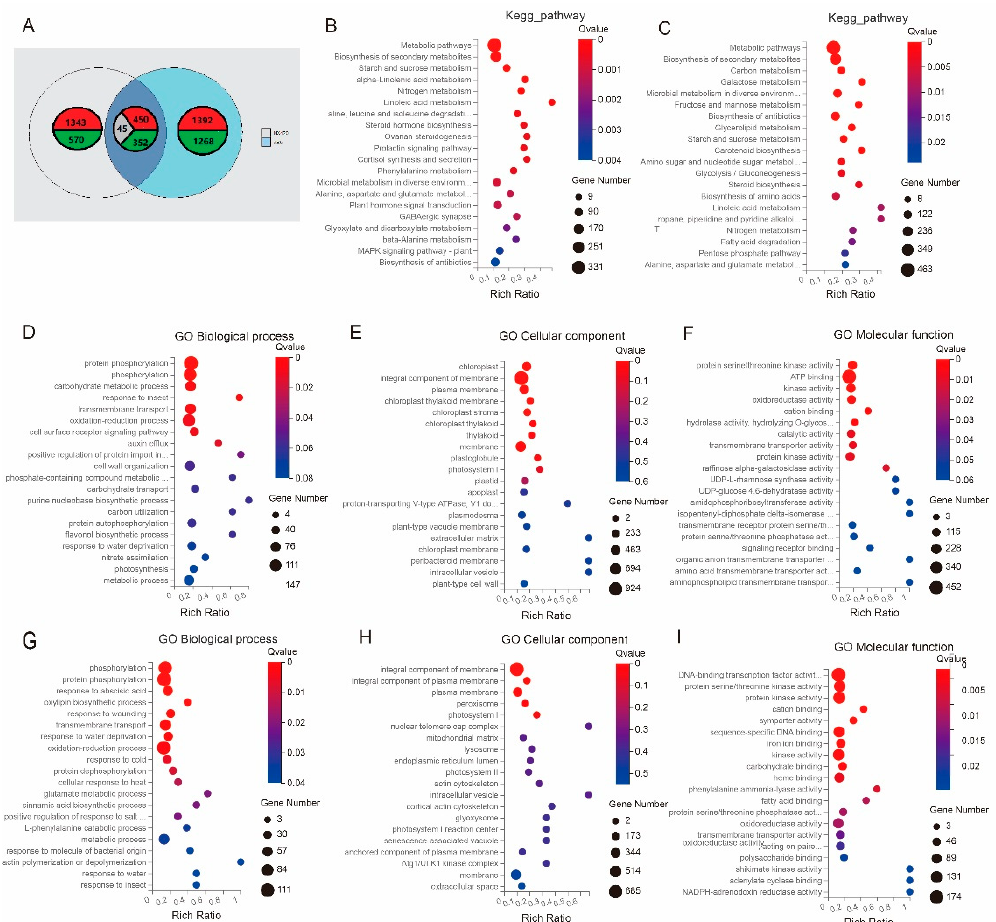
Figure 3. The differentially expressed genes (DEGs) at the seedling stage in NX420 and AS5. ( A ) The number of DEGs and two inbred lines; ( B ) KEGG enrichment at the seedling stage in NX420; ( C ) KEGG enrichment at the seedling stage in AS5; ( D – F ) GO enrichment at the seedling stage in AS5; ( G – I ) GO enrichment at the seedling stage in NX420.